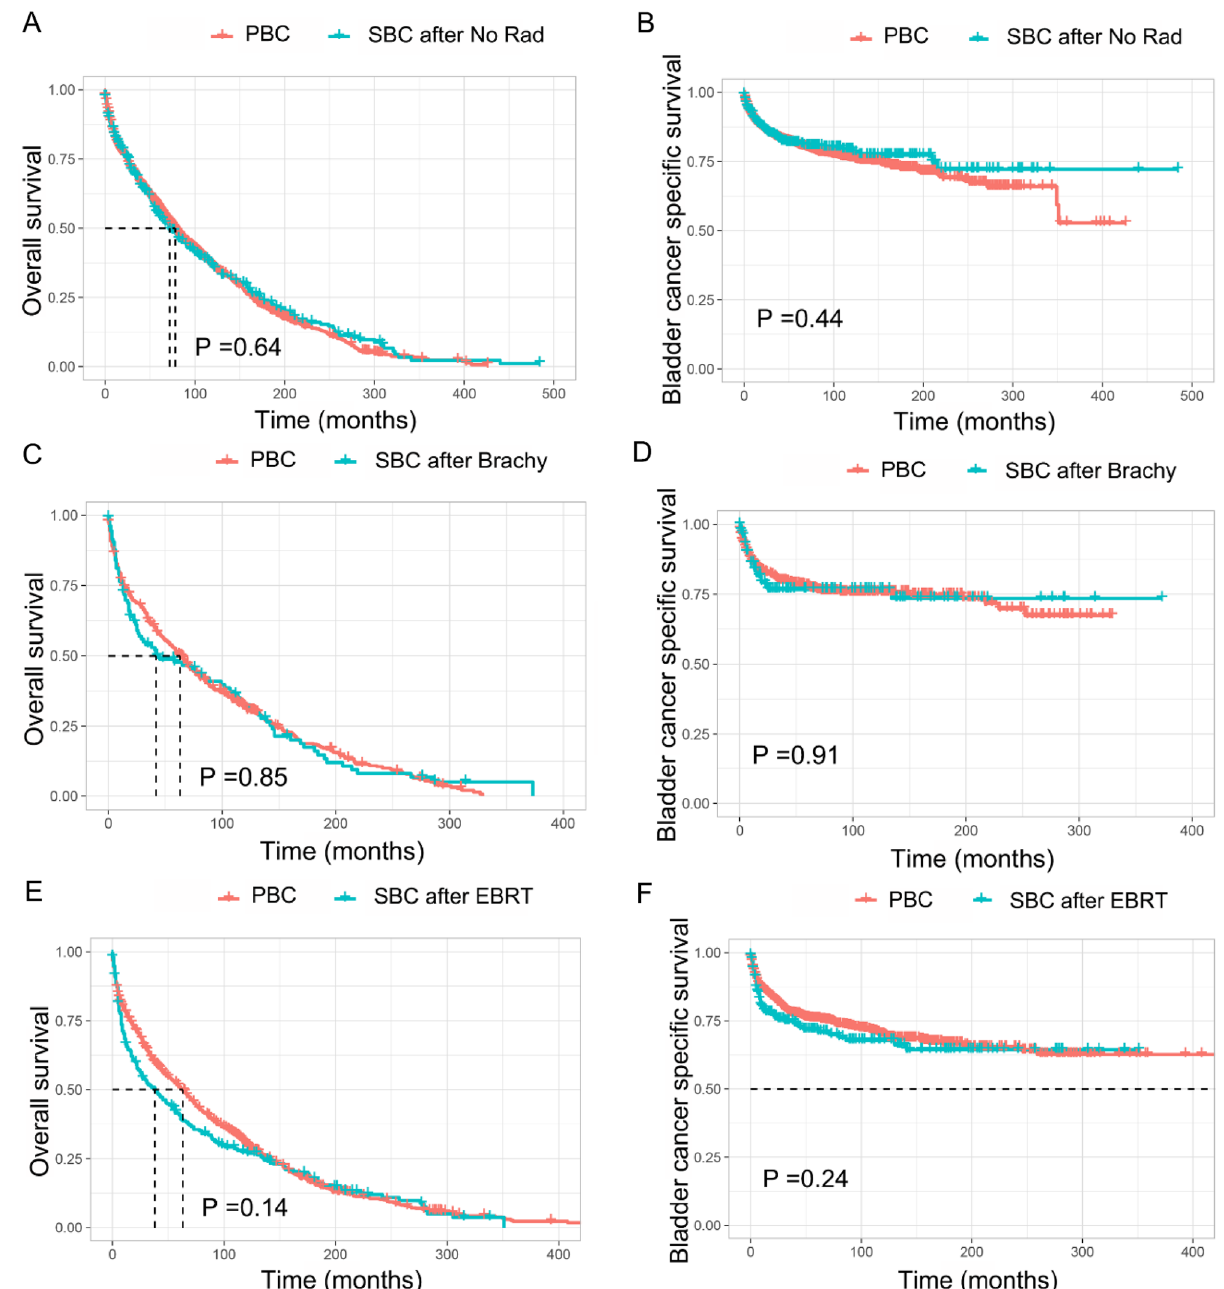
Figure 4. Comparison of survival between PBC patients and SBC patients received different RT modality after EC diagnosis. ( A ) OS between PBC and SBC after no radiotherapy; ( B ) BCSS between PBC and SBC after no radiotherapy; ( C ) OS between PBC and SBC after brachytherapy; ( D ) BCSS between PBC and SBC after brachytherapy; ( E ) OS between PBC and SBC after EBRT; ( F ) BCSS between PBC and SBC after EBRT; OS, overall survival; BCSS, bladder cancer-specific survival; EBRT, external-beam radiotherapy. Rad, Radiotherapy; PBC, primary bladder cancer; SBC, secondary bladder cancer; EC, endometrial